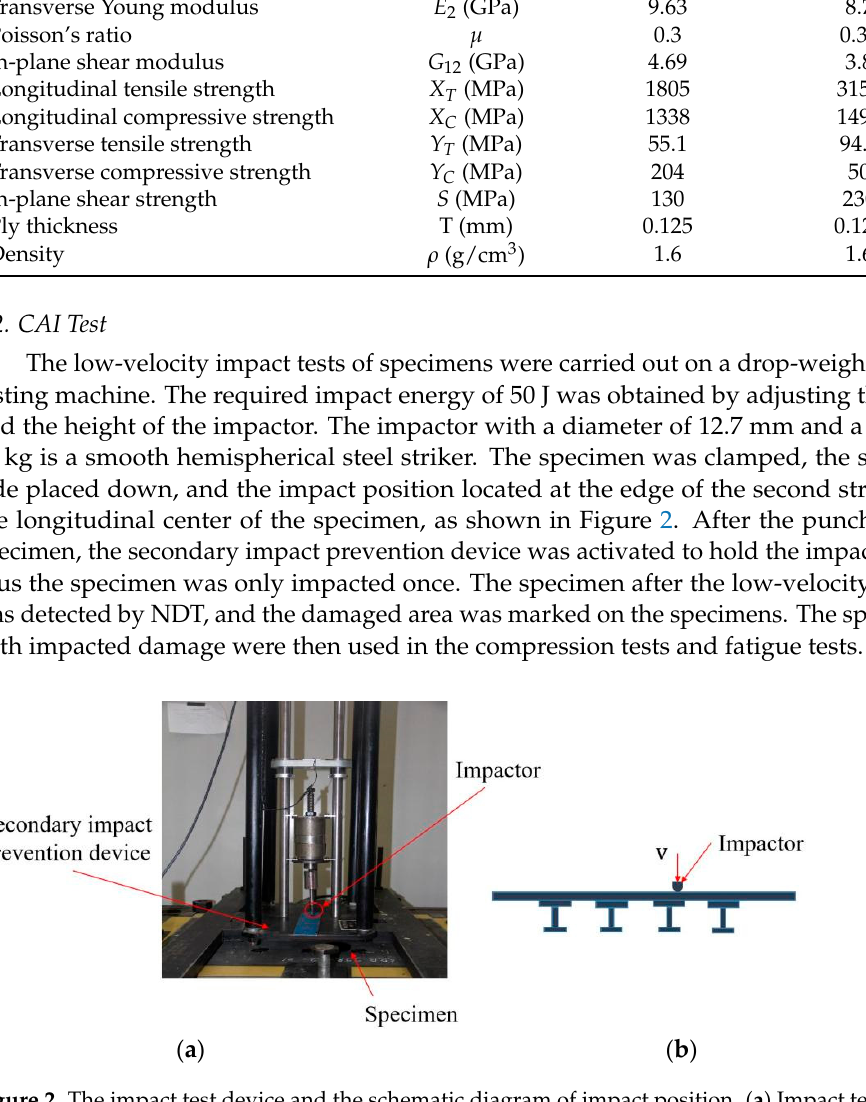
Figure 2. The impact test device and the schematic diagram of impact position. ( a ) Impact test device; ( b ) Impact position.